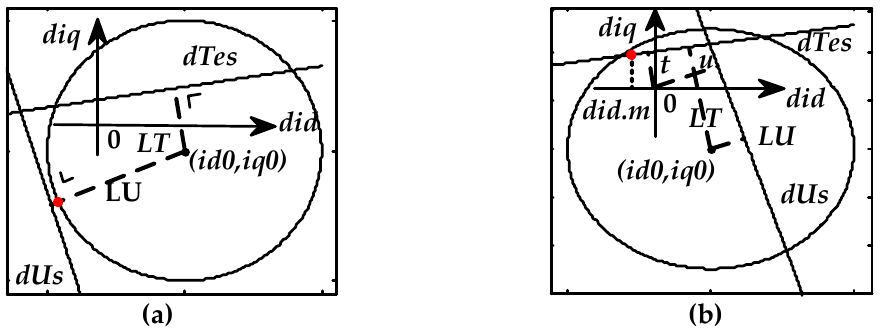
Figure 8. Graphical illustration of the optimal current vector modification: ( a ) voltage incremental line in the outside of current circle; ( b ) The intersection of torque and voltage incremental line in the right hand side of terminal current vector.